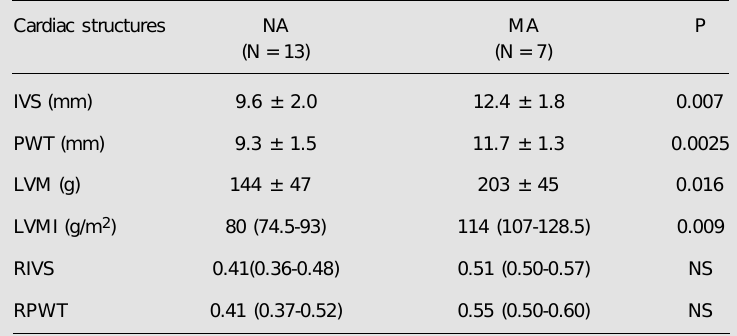
Table 3. Cardiac structure measurements of normoalbuminuric (NA) and microalbu- minuric (MA) patients. Cardiac structures